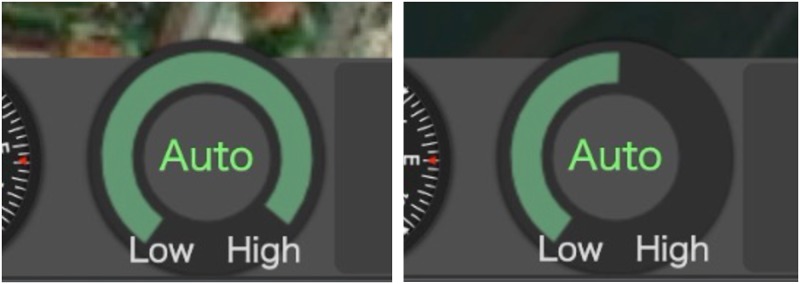
Reliability indicator at the bottom left area of the screen.(A) Showing a higher reliability. (B) Showing a deteriorated reliability.